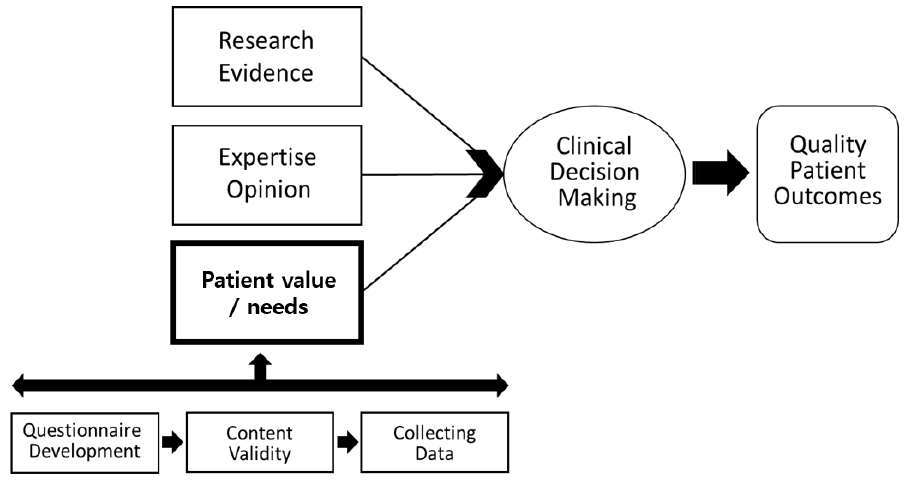
Figure 1. Research frame work [11].